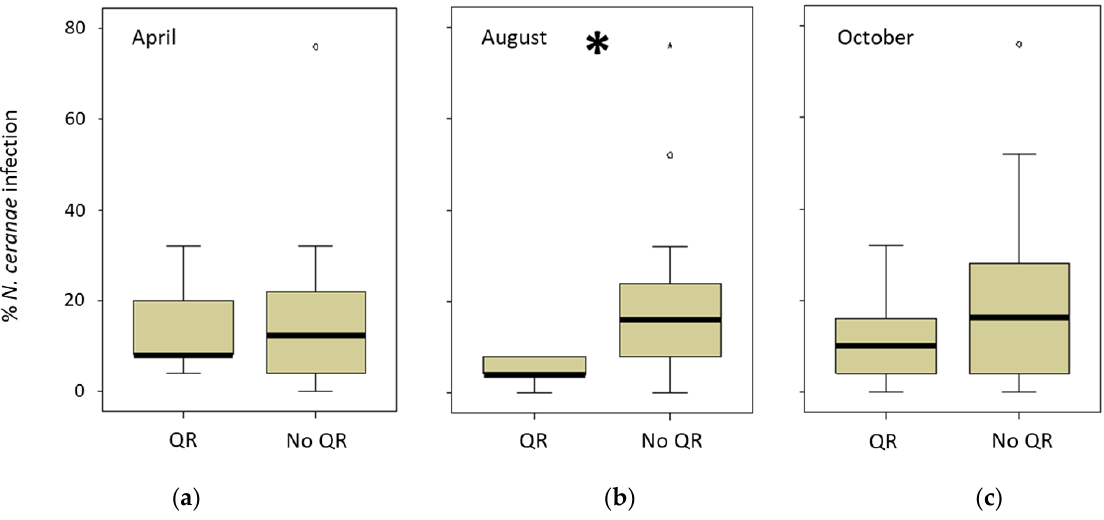
Figure 5. Percentage of intra-colony infection in CIAPA and CIMO colonies in April 2019. The comparison was made between colonies when the queen replacement (QR) was detected in ( a ) April 2019 ( n = 5), ( b ) August ( n = 5), or ( c ) October ( n = 14) versus the colonies that did not replace the queen (No QR) for the same periods ( n = 16; n = 23; n = 14, respectively). * Denotes significant differences ( p < 0.05).